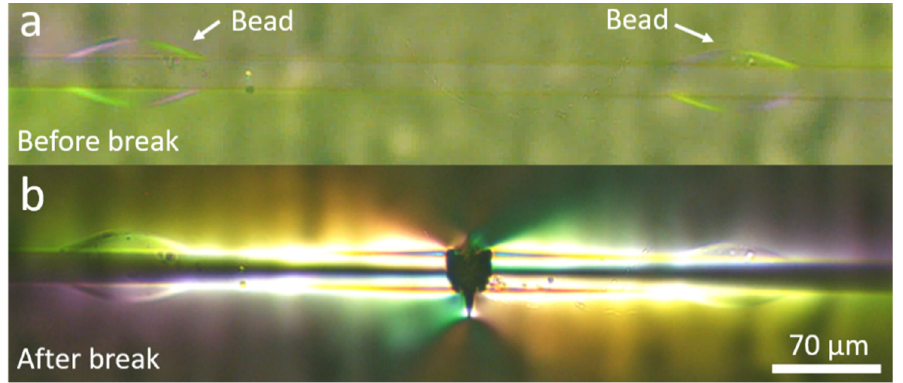
Figure 10. Beaded fibre fragment under load ( a ) before and ( b ) after fibre break. Before fibre break, no residual stress is observed inside beads. After fibre break, beads show stress concentration.